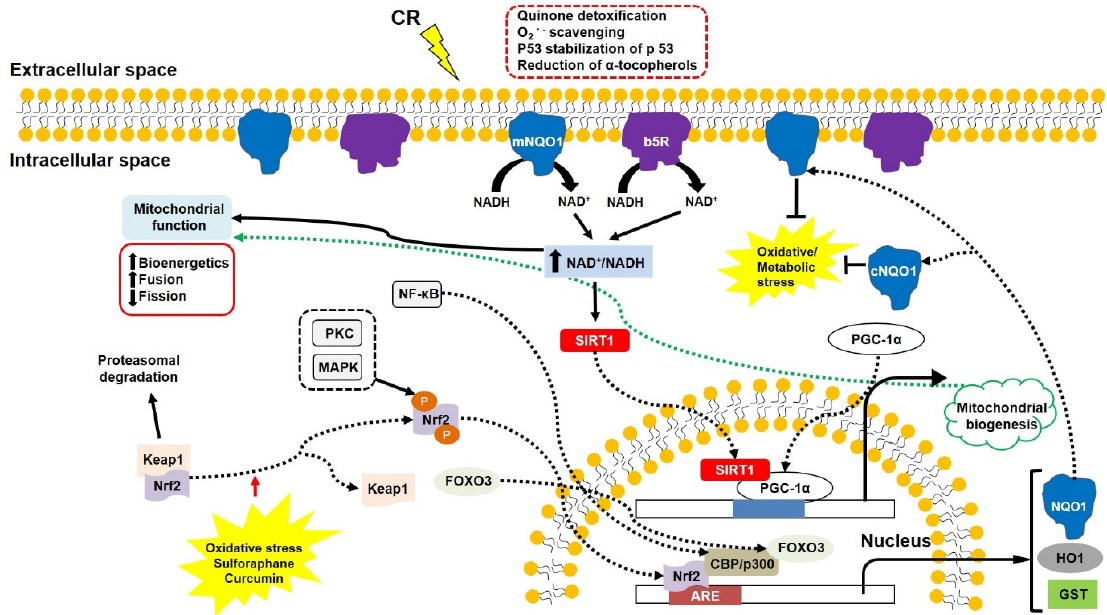
Figure 4. The PM redox enzymes (NQO1 and b5R) play a crucial role in increasing NAD + /NADH ratio and decreasing oxidative/metabolic stress. NAD + /NADH ratio is the key factor in inducing cell survival signalling involving SIRT1, PGC1 α , and Nrf2. SIRT1 and PGC1 α promote mitochondrial biogenesis, and Nrf2 induces ARE expression associated with p300 and FOXO3. Some phytochem- icals can break the Nrf2–Keap1 linkage, inducing detoxifying enzymes. Abbreviations: ARE, anti- oxidant response element; b5R, cytochrome b5 reductase; CBP, transcriptional coactivators of CREB binding protein; CR, calorie restriction; FOXO3, O subclass 3 of the forkhead family of transcription factors. GST, glutathione S-transferase; HO1, heme oxygenase 1; Keap1, Kelch-like ECH-associated protein 1; MAPK, mitogen-activated protein kinase; NF-kb, nuclear factor kappa-light-chain-en- hancer of activated B cells; NQO1, NADH-quinone oxidoreductase 1; cNQO1, cytosolic NQO1; mNQO1, membrane-bound NQO1; Nrf2, nuclear factor erythroid-2-related factor 2; PGC1 α , perox- isome proliferator-activated receptor gamma coactivator 1- α ; PKC, protein kinase C; SIRT1, silent mating type information regulation 2 homolog 1.